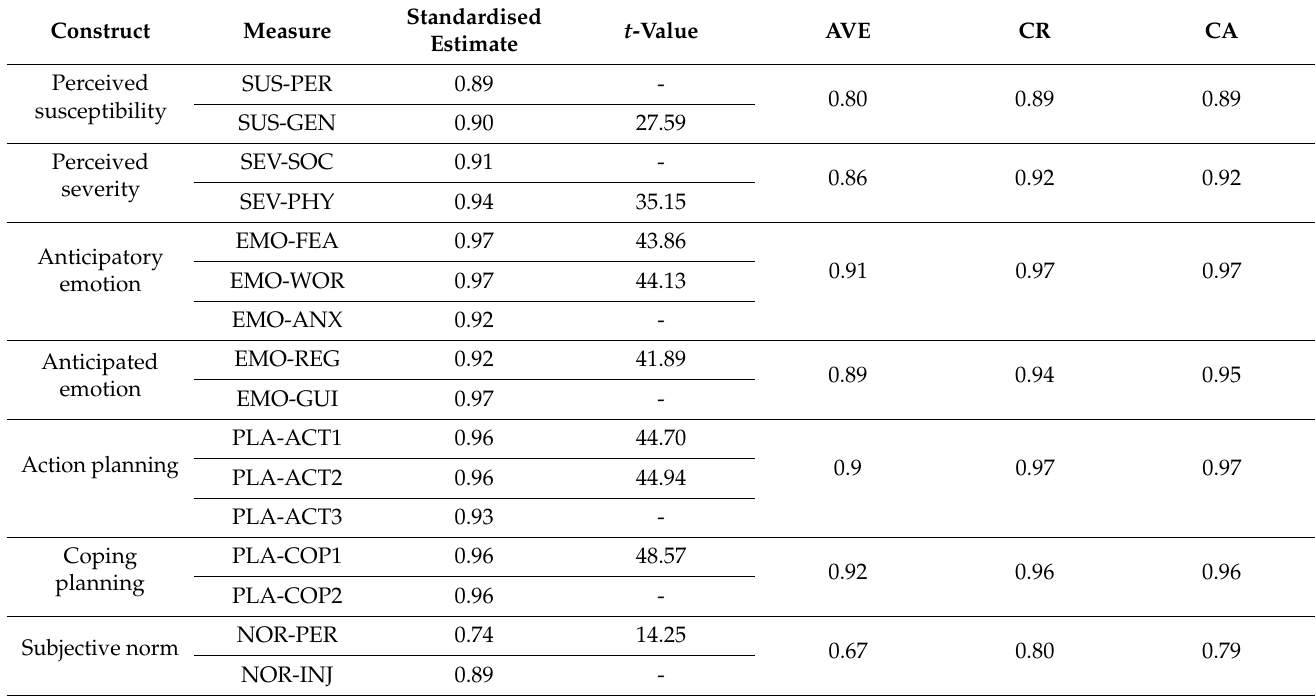
Table 3. Confirmatory factor